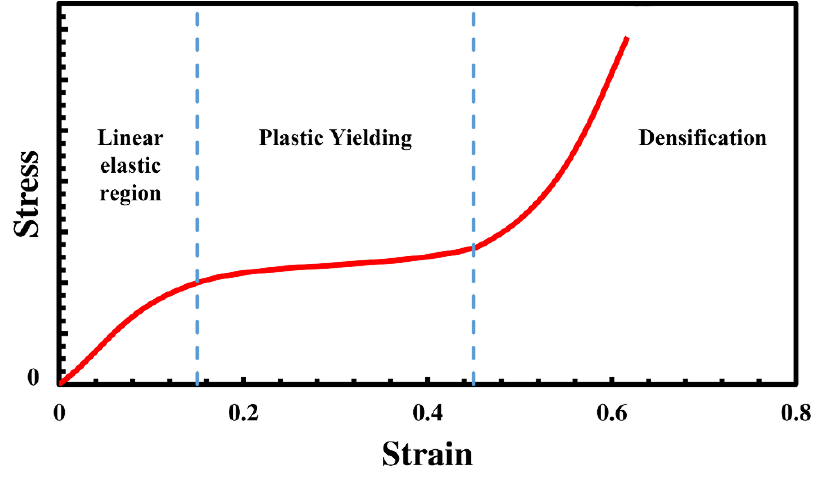
Figure 2. A typical stress-strain curve for NP Au under compressive deformation